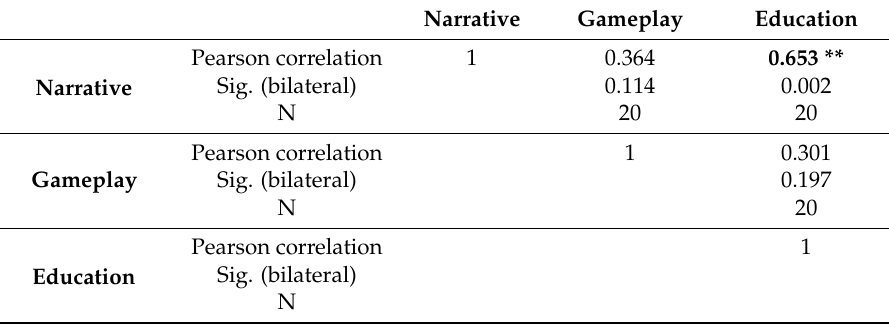
Table 6. Pearson correlations by dimensions.